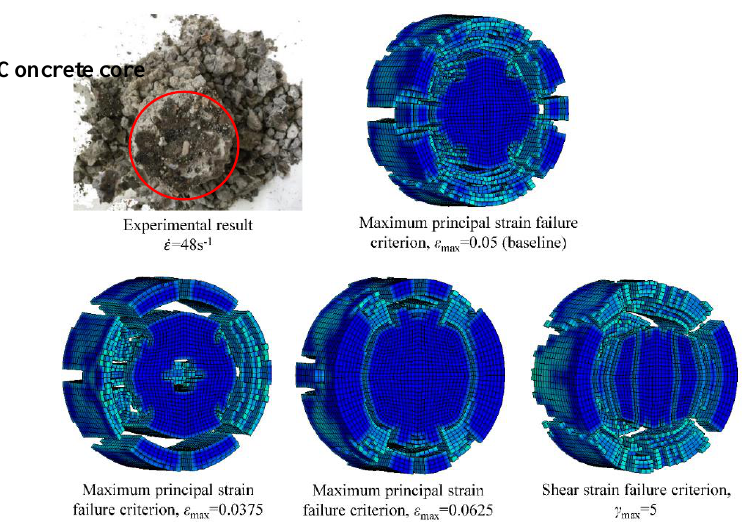
Figure 10. Comparative failure patterns of the specimens after being impacted with the test results.